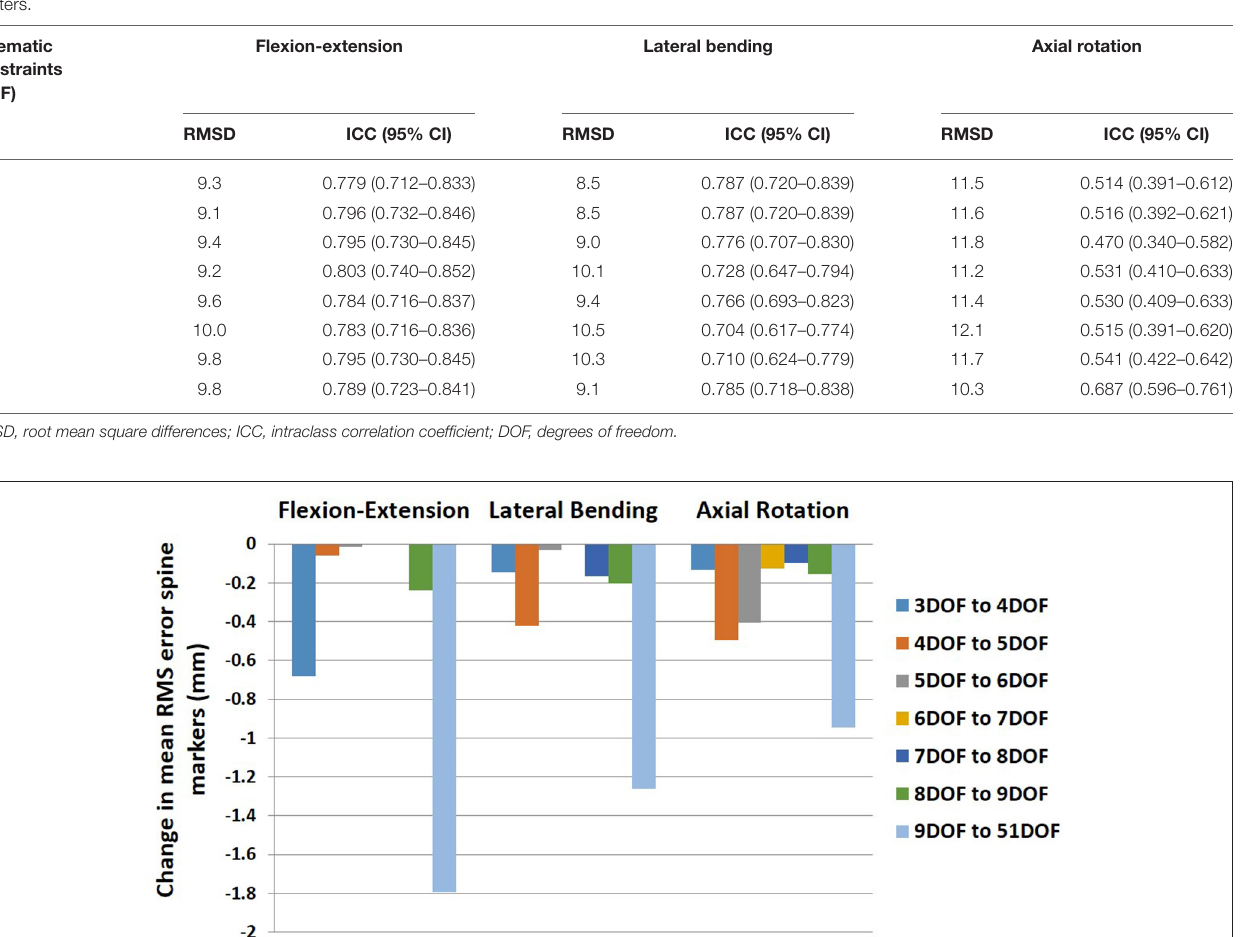
inverse kinematics without kinematic constraints (51DOF) is unsuitable for characterizing in vivo spine